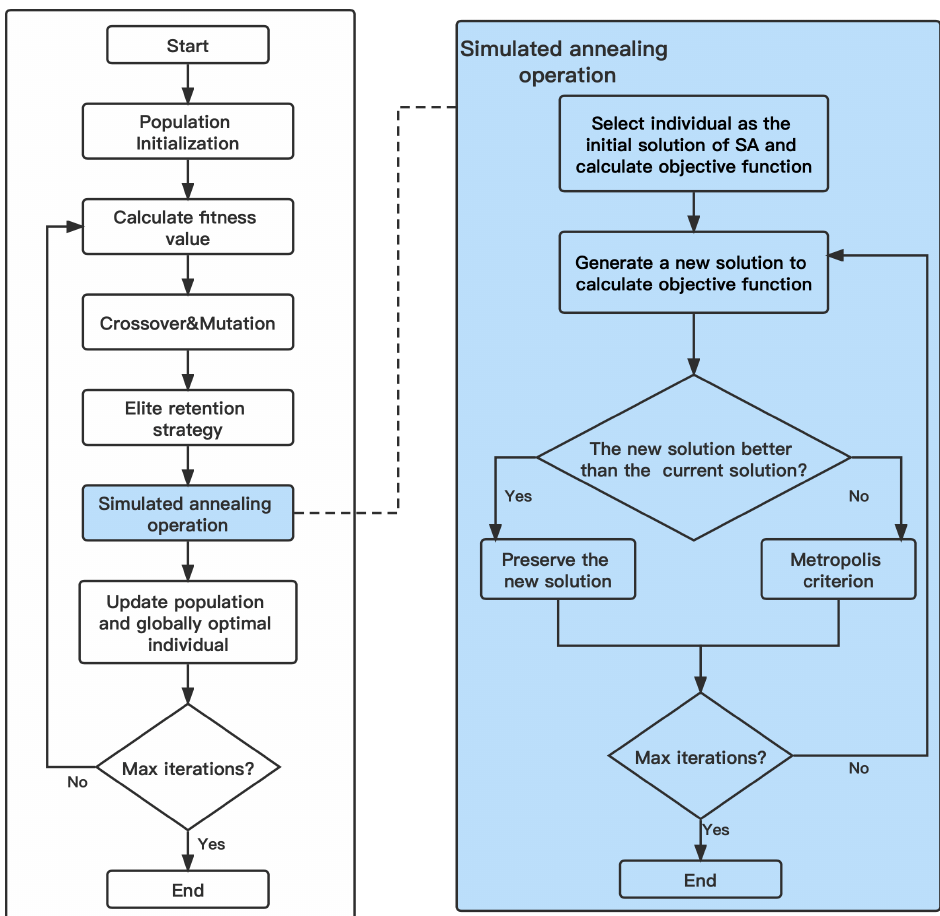
Figure 3. Flowchart of the H-GASA